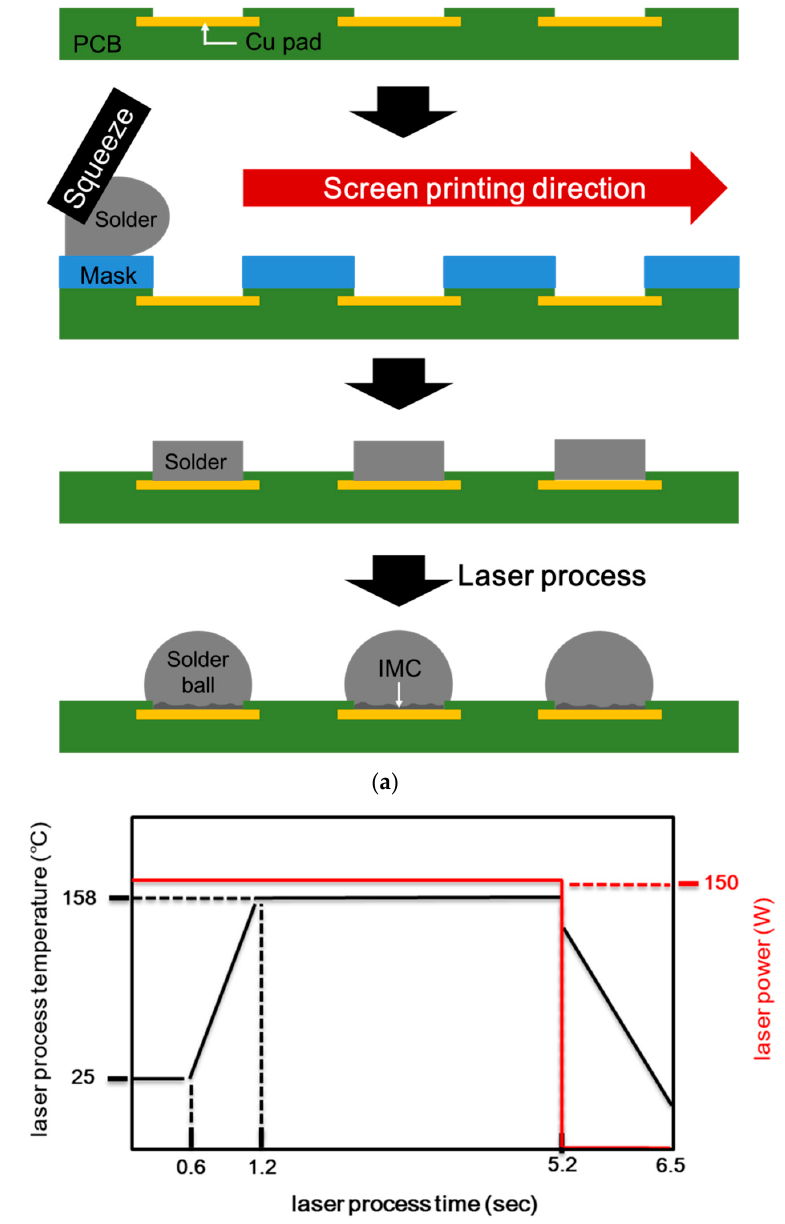
Figure 1. ( a ) Schematic of the fabrication process for test samples and ( b ) profiles for bonding conditions by the laser process.